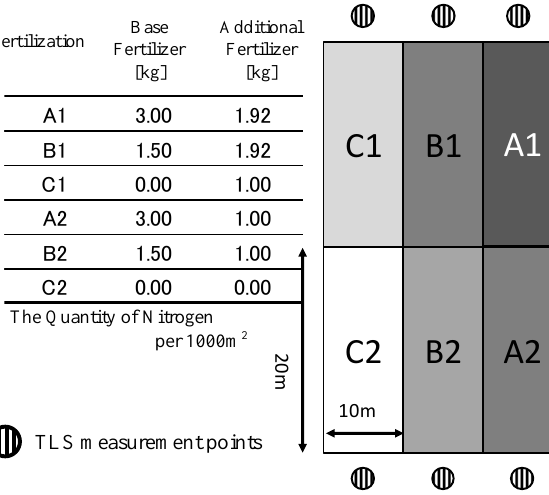
Fig.1 Experimental site and fertilization blocks